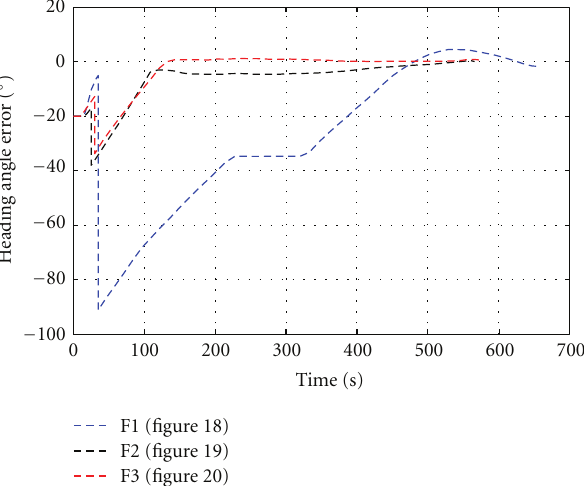
Figure 21: Errors in heading angles of the experiments.